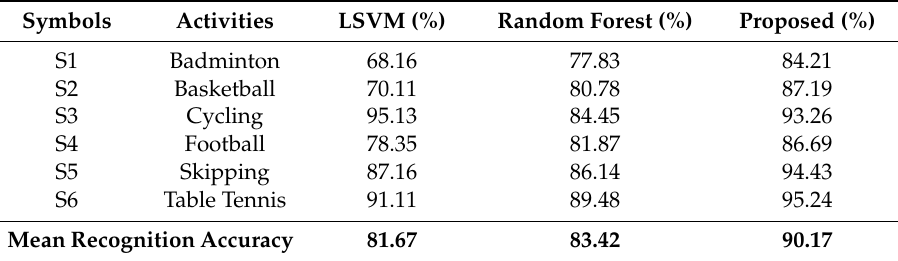
Table 8. The Intelligent Media-Sporting Behavior (IM-SB) dataset results over the proposed classifier and other well-known statistical classifiers.